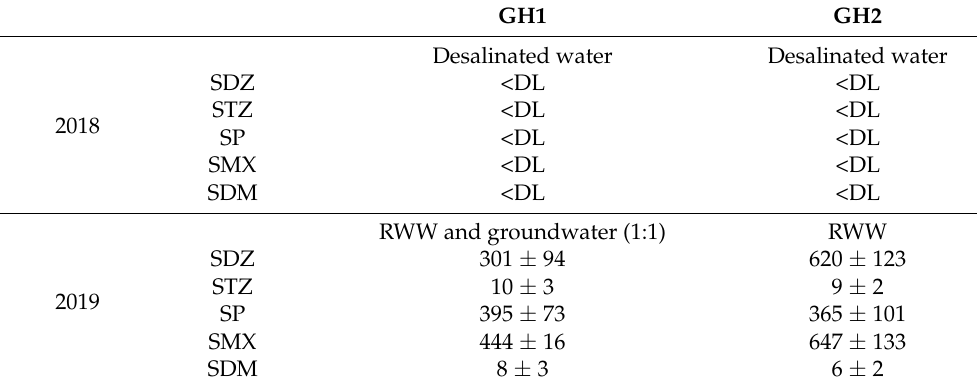
Table 2. Irrigation water source over two years and the concentration of sulfonamides (ng L − 1 ) (sulfa- diazine (SDZ), sulfathiazole (STZ), sulfapyridine (SP), sulfamethoxazole (SMX) and sulfadimethoxine (SDM)). Data are represented as the mean ± standard deviation, n = 3. <DL indicates below the detection